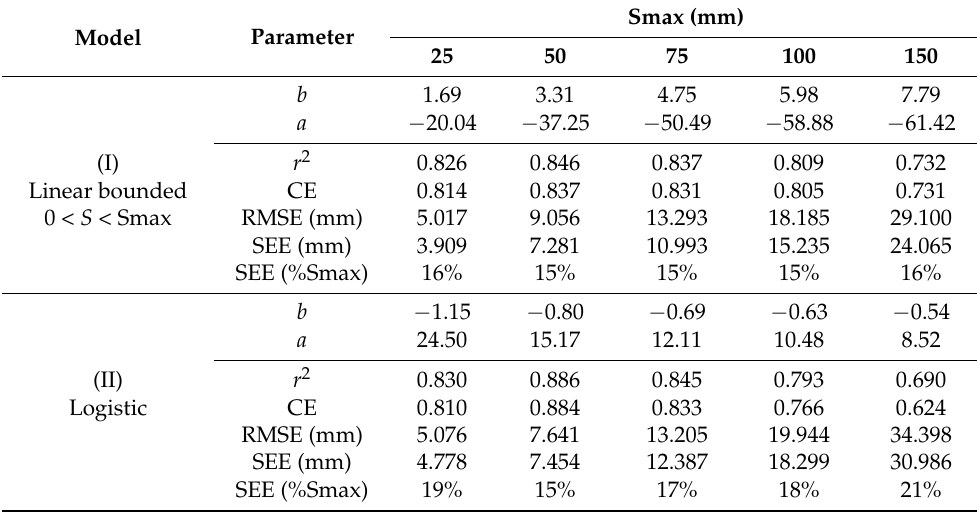
Figure 5. Monthly series of soil moisture (SM), an ESA satellite product, and soil water storage ( S ), an outcome of the Thornthwaite–Matter water balance that was computed for Bragança (Smax = 100 mm).